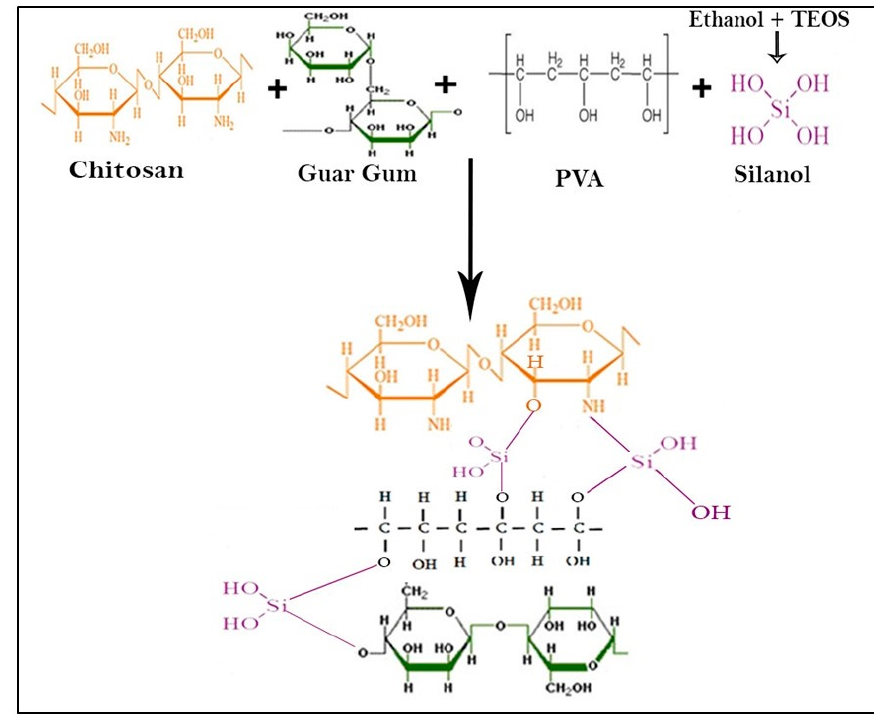
Scheme 1. Drug loaded